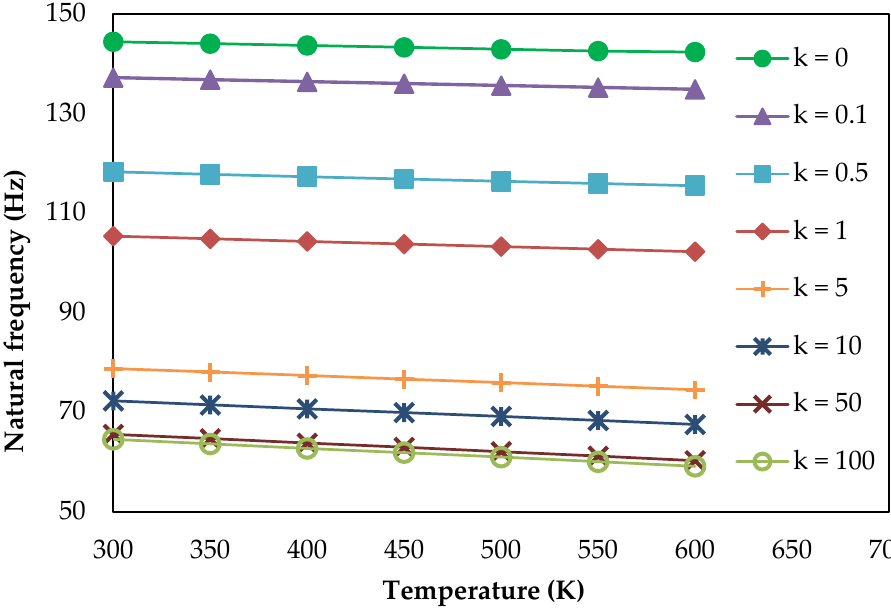
Figure 9. Variation of the natural frequency of a Ti-6Al-4V/silicon carbide FGM shell in uniform thermal field for different material composition for re-entry vehicle nose structures.